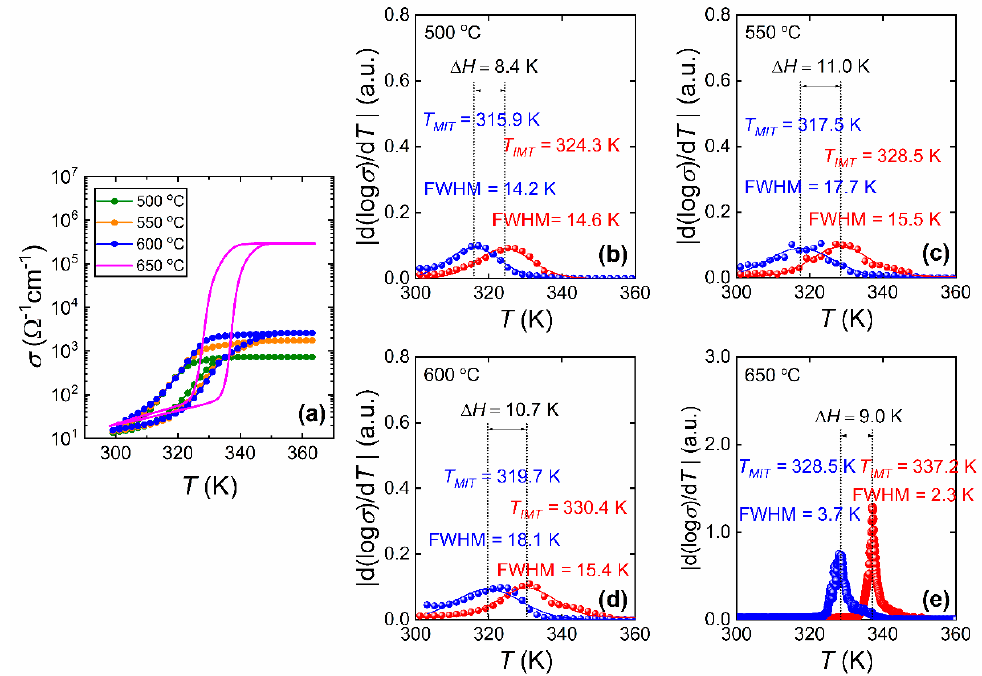
Figure 10. Temperature ( T ) dependence of electrical conductivity ( σ ) of VO 2 films prepared at various substrate temperatures ( T S ). ( a ) Comparison of T dependence of σ of films prepared at T S = 500 °C, 550 °C, 600 °C, and 650 °C [32]. The phase transition characteristics for heating and cooling cycles for films prepared at T S = ( b ) 500 °C, ( c ) 550 °C, ( d ) 600 °C and ( e ) 650 °C [32].